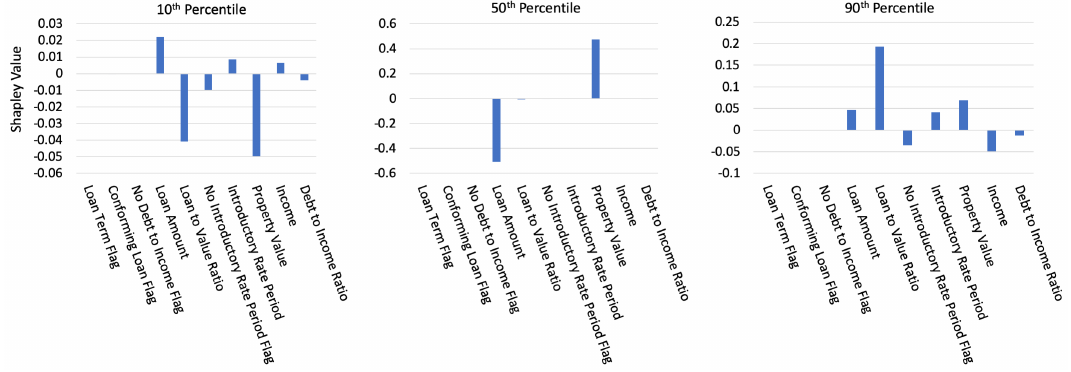
Figure 7. Deep SHAP values for three individuals across selected percentiles of g XNN ( X ) on the mortgage test